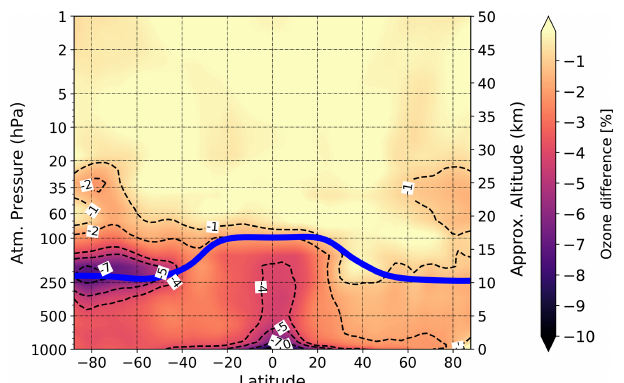
Figure 7. Modeled effect of iodine chemistry on annual-mean ozone climatology excluding I-Cl and I-Br cross-halogen reactions, averaged for the 2000–2009 period. Presented ozone changes of the case with present-day iodine emissions (1 × iodine) relative to the control run (0 × iodine). Blue solid line: annual mean tropopause